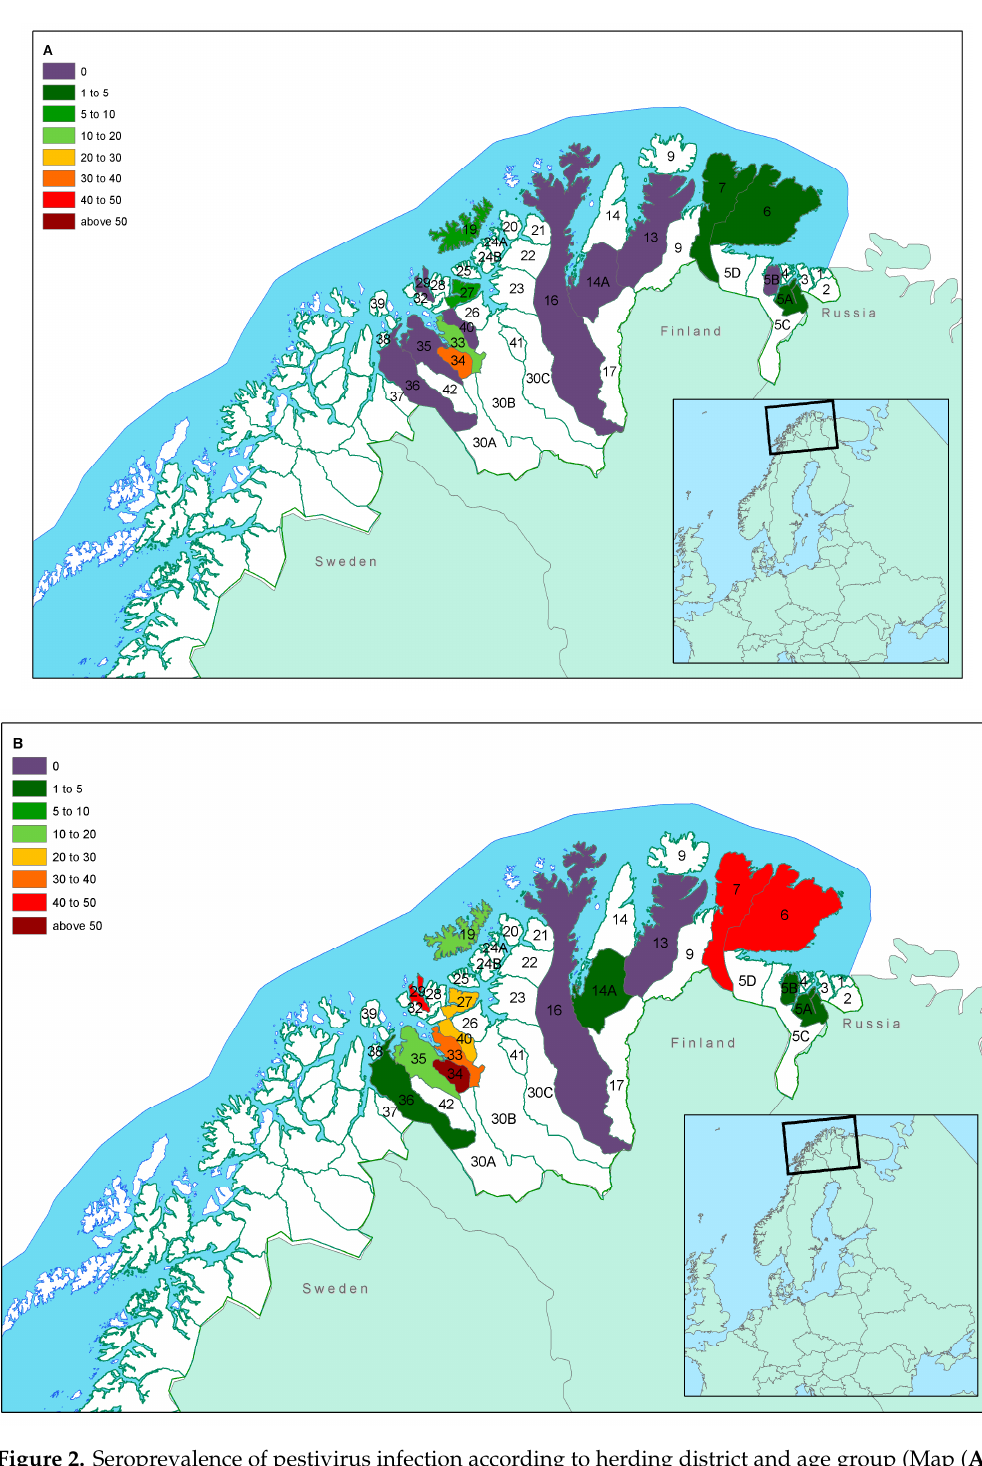
Figure 2. Seroprevalence of pestivirus infection according to herding district and age group (Map ( A ): calves; map ( B ): adults) in Finnmark County, Norway. Tables 1 and 2 provide detailed information on age distribution within districts that should be considered when extrapolating the seroprevalence to the general population in each district. The border between western and eastern Finnmark is between districts 16 and 14A.